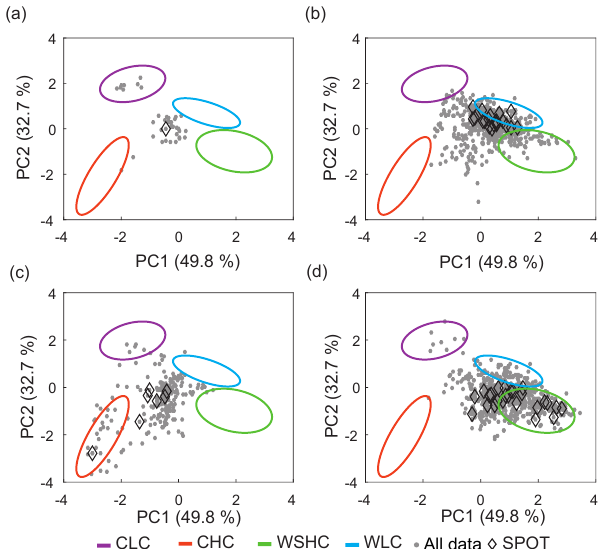
Figure 5. Cross-channel coherence. SPOT profiles were grouped by PCA quadrant. Panel (a) displays SPOT profiles (diamonds) and the corresponding non-SPOT profiles (grey dots) that were collected during the same glider transect when SPOT was most similar to the CLC end-member. Similarly, panels (b) , (c) , and (d) display the profiles for which SPOT was most similar to the WLC, CHC, and WSHC end-members,